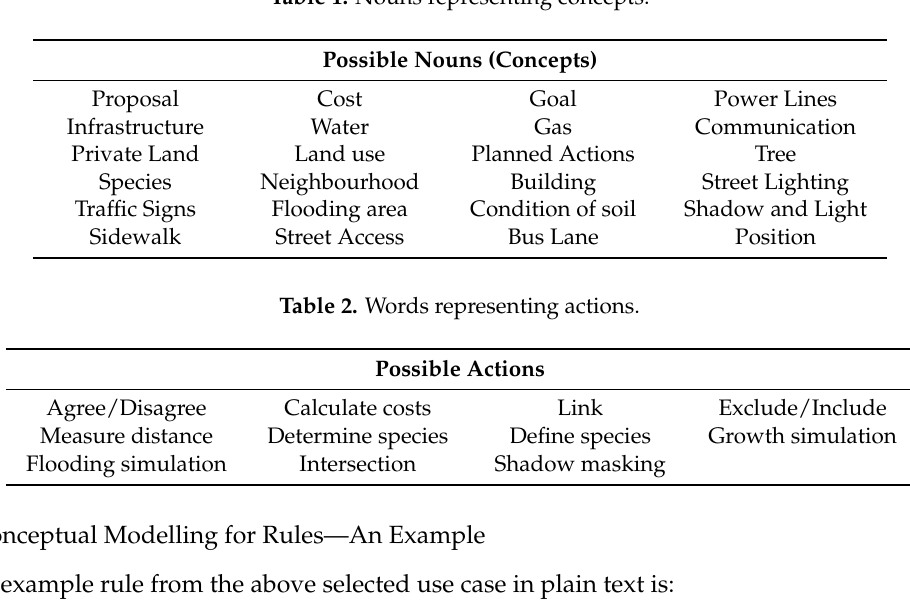
Table 1. Nouns representing concepts.